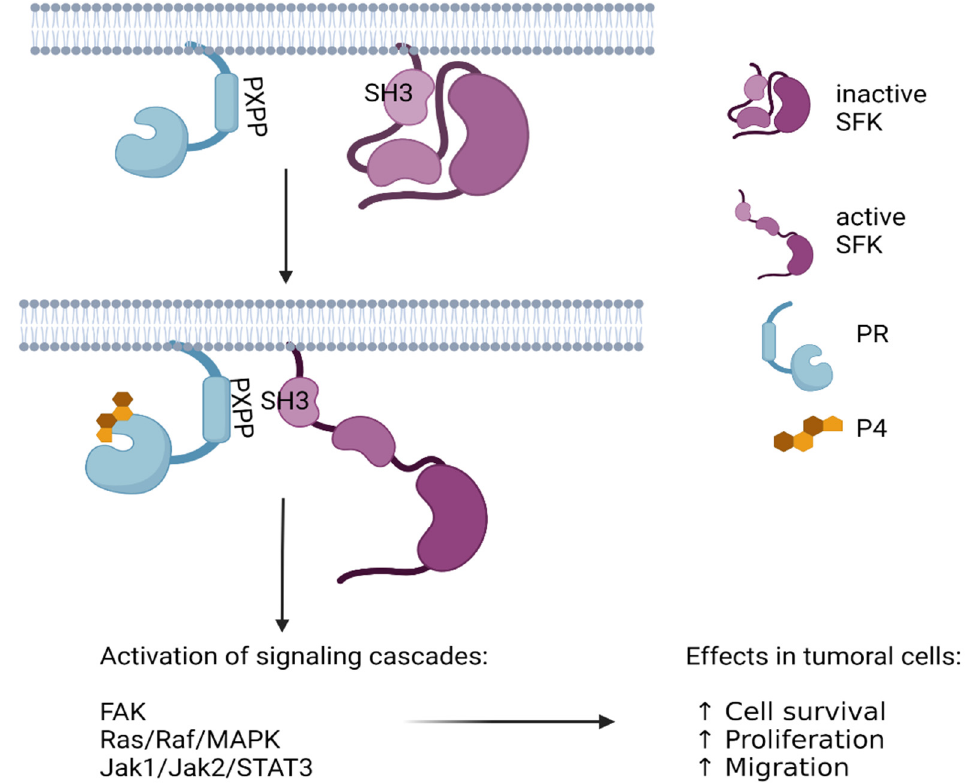
Figure 1. Activation of SFKs by SH3–PXPP interaction. In the cytoplasm or even anchored to the plasma membrane, PR interacts with other cytoplasmic molecules leading to the activation of various signaling cascades. Via PXPP, this receptor interacts with the SH3 domains of several molecules such as cSrc kinase. A direct interaction between cSrc and PR causes a conformational change in cSrc towards its active form and promotes the activation of other signaling cascades such as mitogen-activated protein kinases (MAPKs) that favor cancer progression by enhancing cell survival, proliferation, and migration.